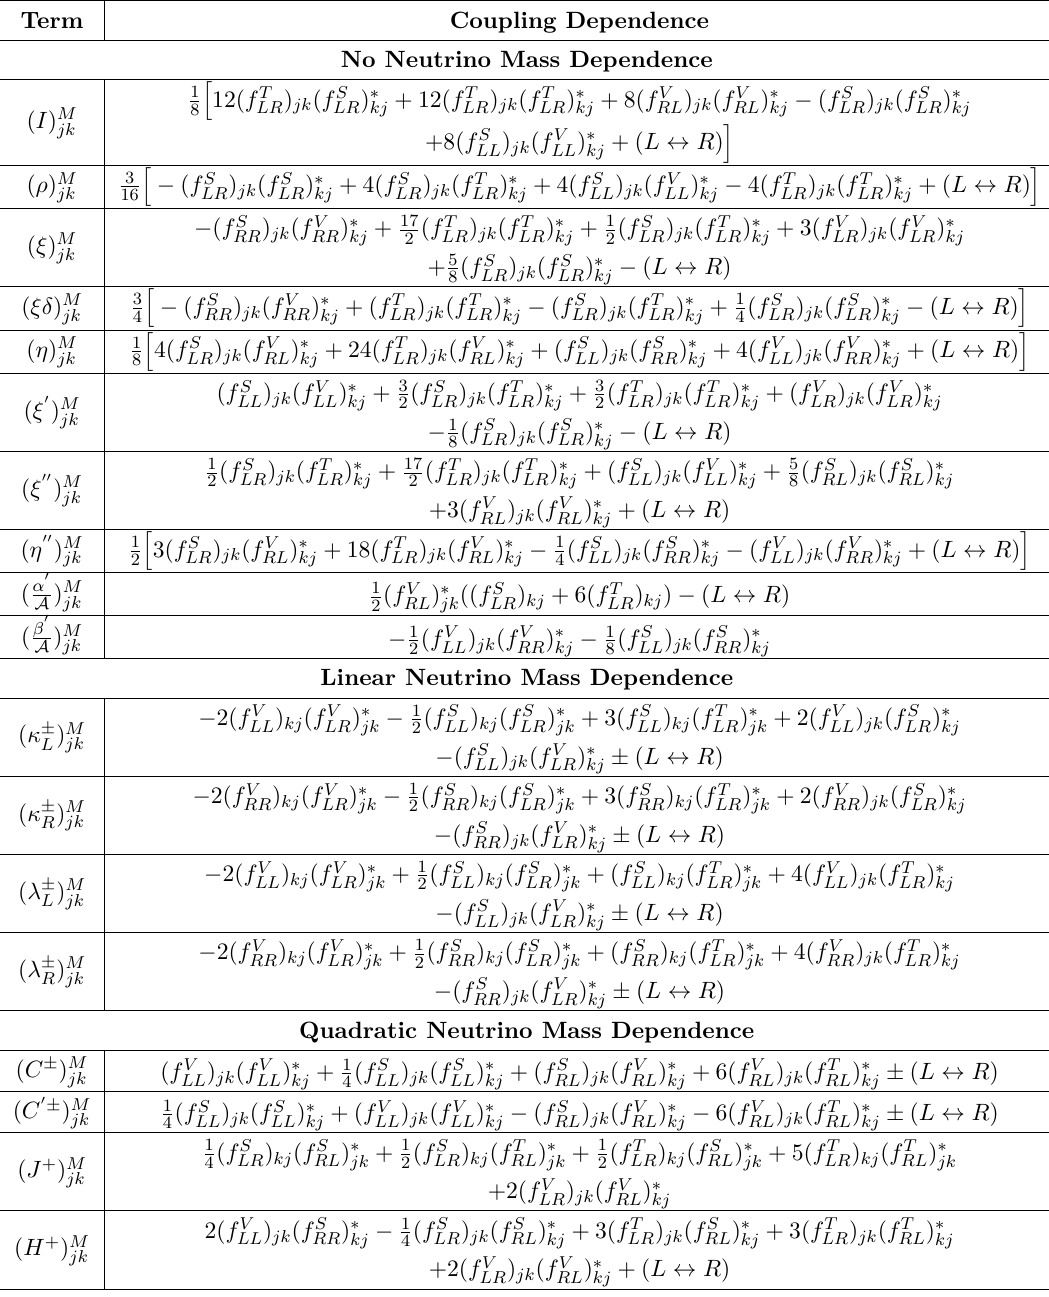
Table 6. Majorana term for the general coupling